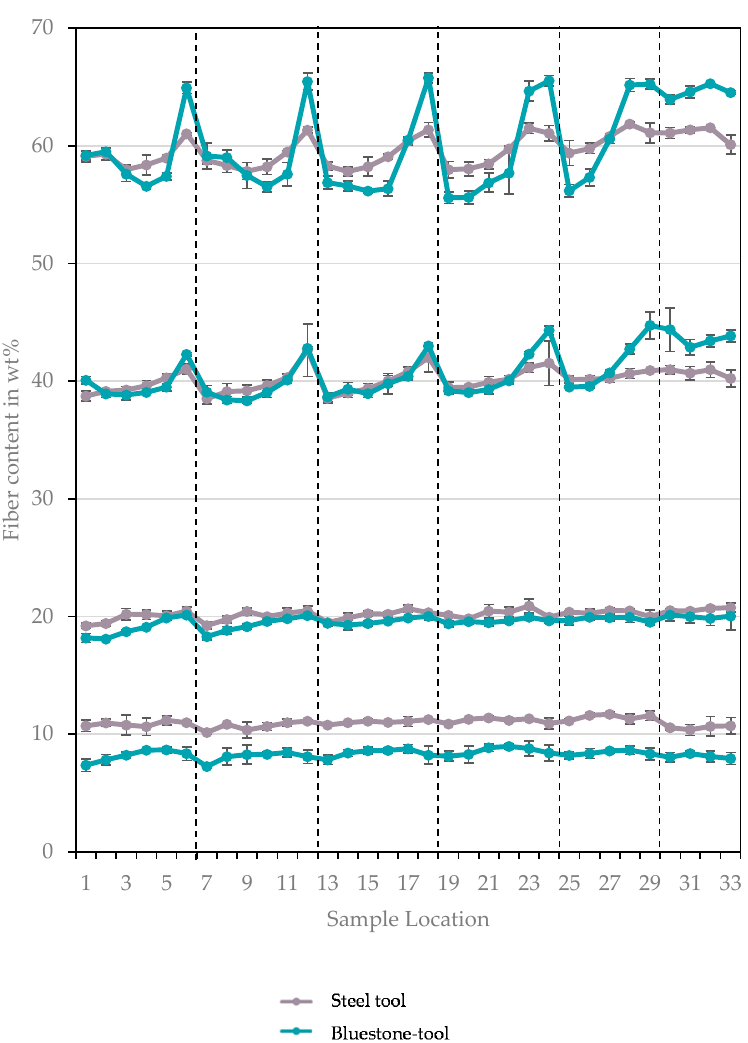
Figure 20. Fiber content distribution for disc segments of 10 wt.%, 20 wt.%, 40 wt.%, and 60 wt.% initial nominal fiber content at different locations (1–33 in accordance with Figure 7) for steel tools and Bluestone tools.